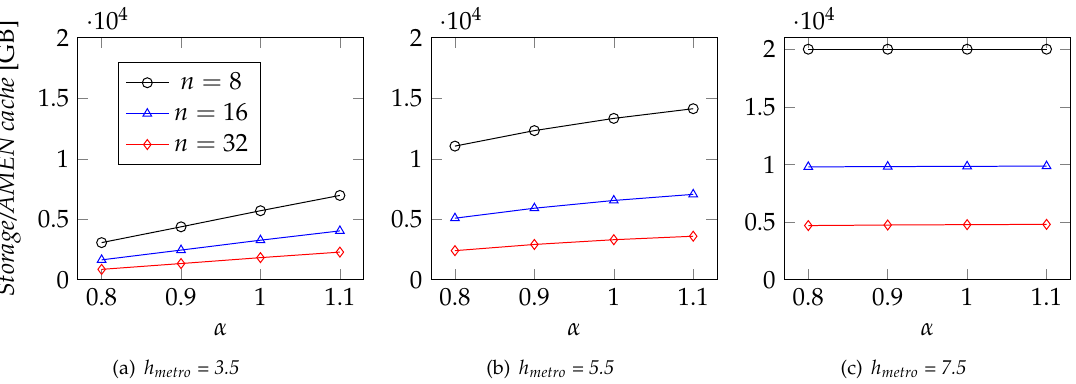
Figure 6. The amount of storage capacity of the AMEN caches corresponding to the best cache deployment when utilizing 8, 16 or 32 caches for different values of α and h metro .